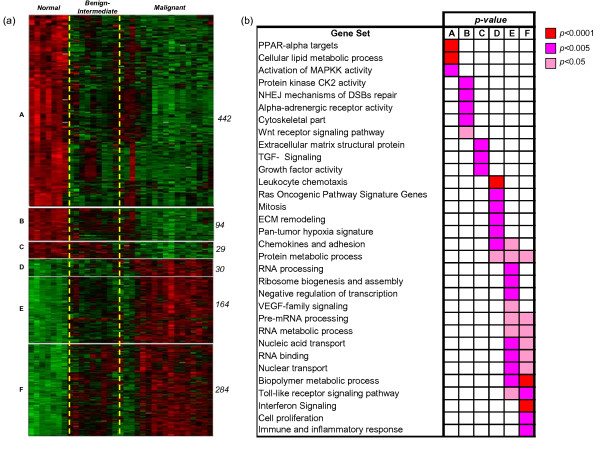
Identification of gene classes in canine mammary samples. (a) Hierarchical clustering of dog samples based on a subset of 1043 genes selected by 1-way ANOVA (q-value < 0.001). For display purposes, samples in each class (normal, intermediate-benign, malignant) were clustered separately and arranged from normal (left) to malignant (right). Genes were grouped in six groups according to their pattern of expression (see description in the text) and hierarchically clustered separately. The gene size of each group is indicated to the right of each cluster. (b) Graphical representation of the significance of gene set enrichment for the six gene groups described in (a). Enrichment scores are computed by one-sided Fisher's exact test, using the entire set of orthologous genes represented on both human and dog microarray platforms as the reference population.